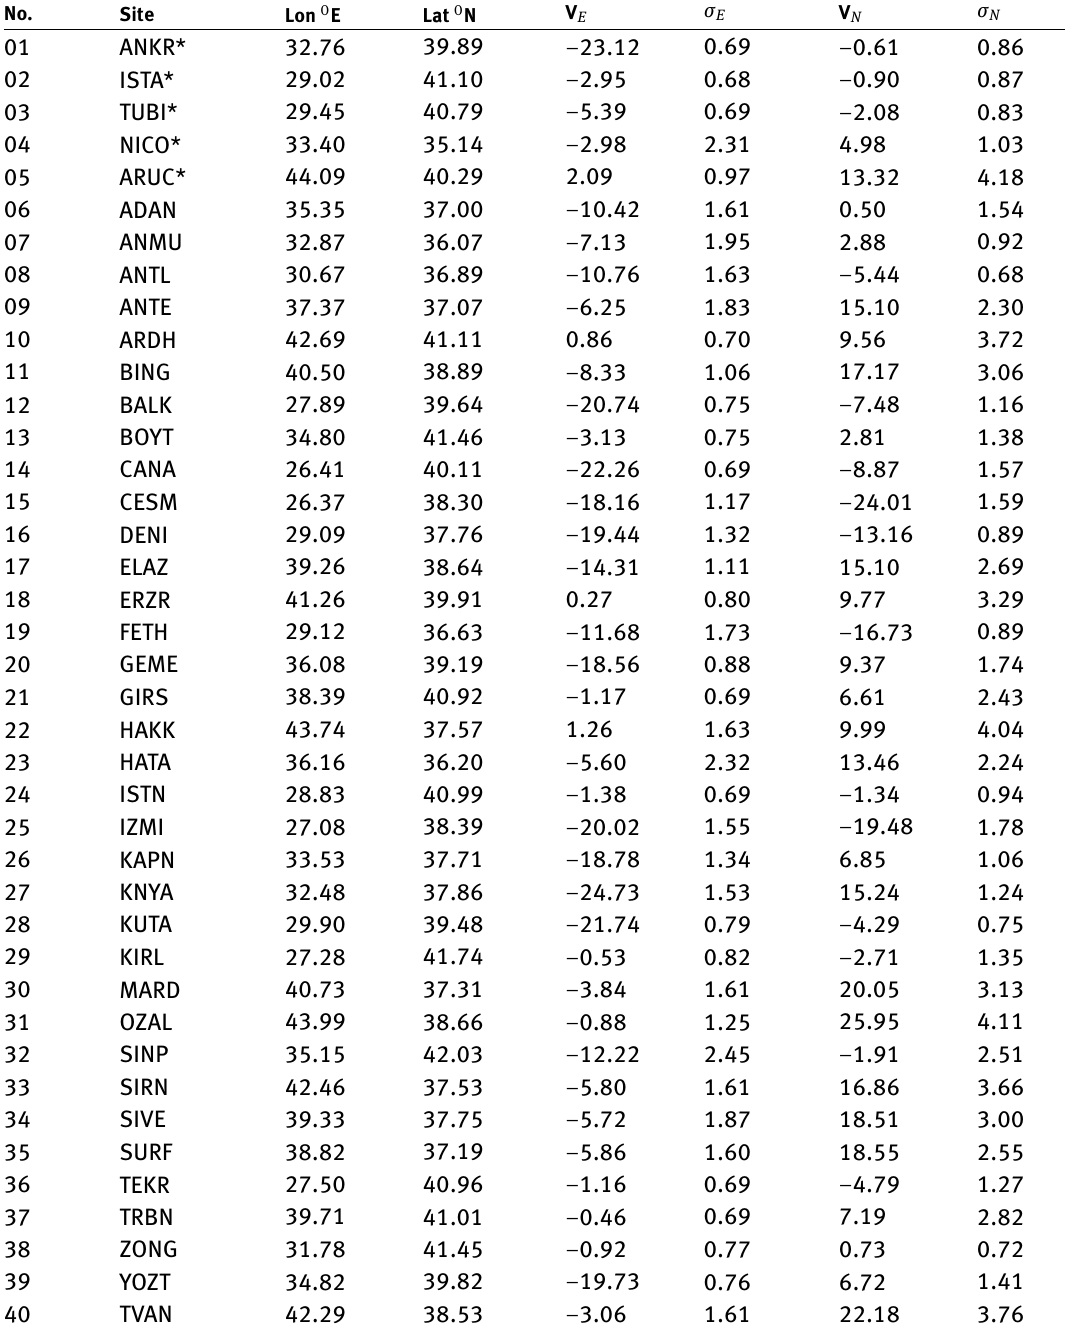
Table 2: The list of IGS (*) and TPGN sites and corresponding velocities plus errors used in the